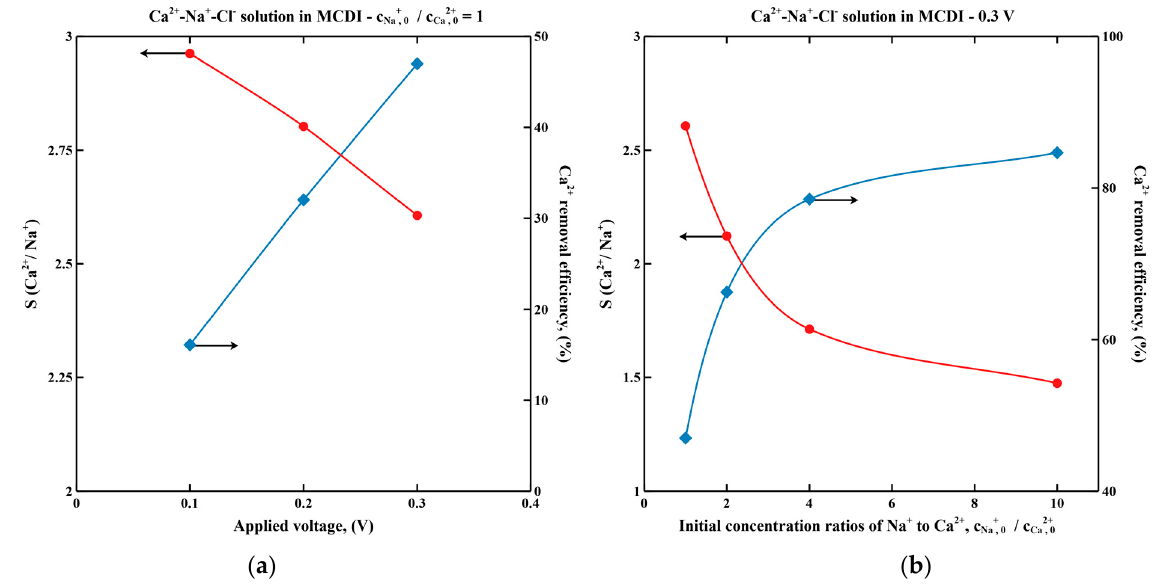
Figure 3. Simulated Ca 2+ selectivity and Ca 2+ removal efficiency in Ca 2+ -Na + -Cl − solution during desalination in cut-off mode MCDI. ( a ) Feed concentration of each cation is 20 mol/m 3 . Applied voltages are 0.1 V, 0.2 V and 0.3 V, respectively; ( b ) Feed concentration of Na + is 20 mol/m 3 , while feed concentrations of Ca 2+ are 20 mol/m 3 , 10 mol/m 3 , 5 mol/m 3 and 2 mol/m 3 , respectively. Applied voltage is 0.3 V. Ratio of hard sphere diameter to hydraulic diameter, C is taken as 1.25. Table 3. Water softening performance and energy behaviors of quasi-steady state MCDI for partially softening industrial cooling tower blowdown